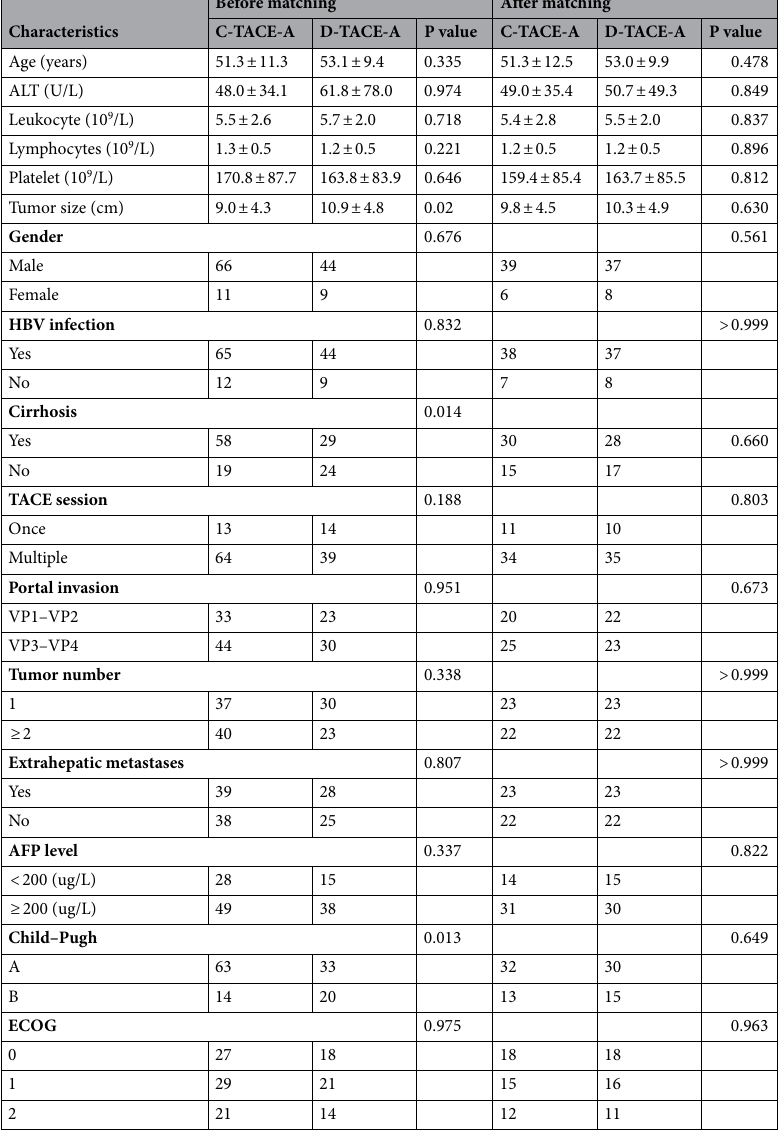
Table 1. The baseline characteristics of patients before PSM and after